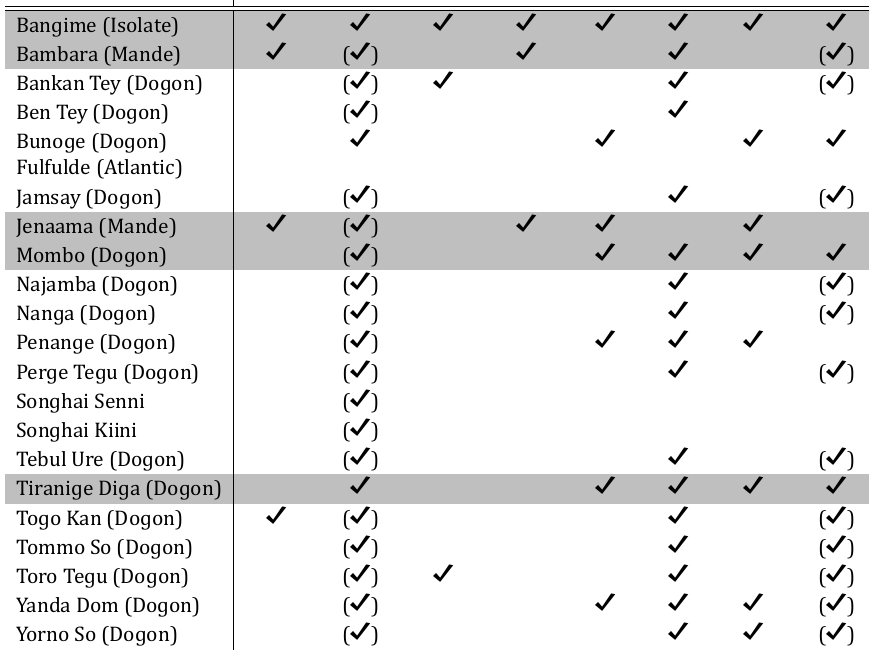
Table 9: Bangime vocabulary shared with Dogon, and Mande